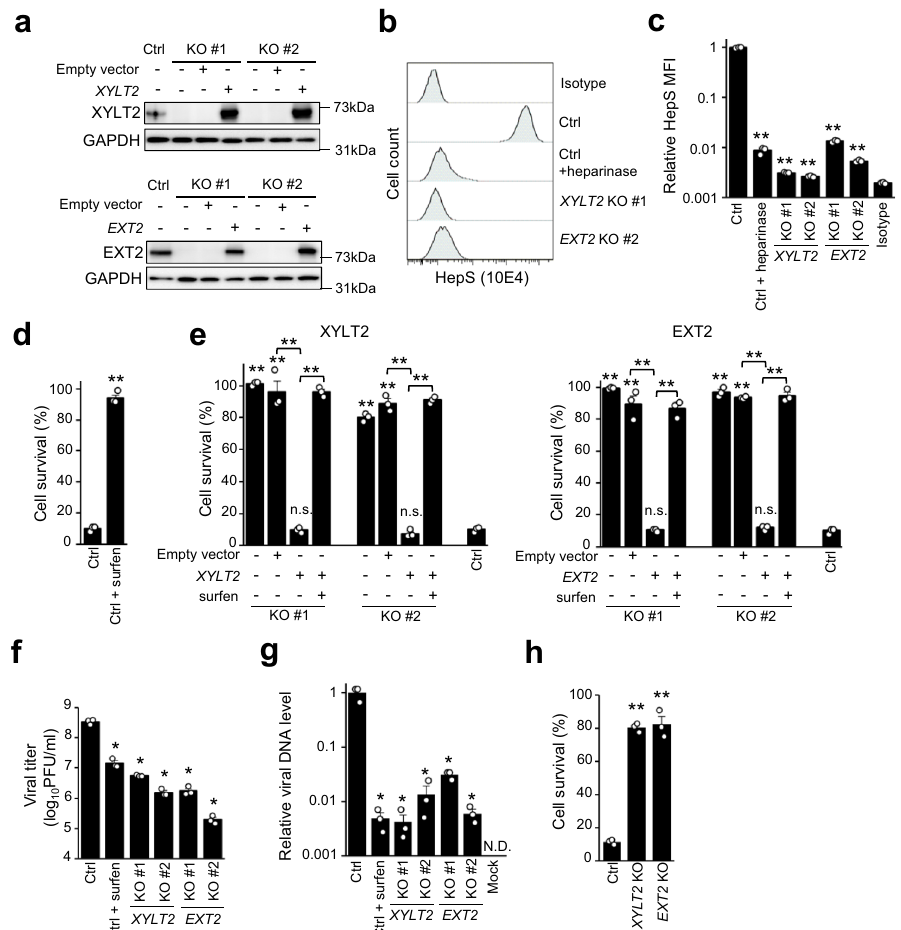
Fig. 2 XYLT2 and EXT2 as essential genes for HSV-1 binding and infection. a Western blotting analysis con fi rming the absence or complementation of XYLT2 , the EXT2 expression in KO, and rescued clones of HAP1 cells. b , c HepS expression analysis by FACS. After treatment with or without heparinase for 1 h at 37 °C, the cells were stained using an anti-HepS antibody. The graph summarized the mean fl uorescent intensity (MFI) of the HepS expression analysis of three independent experiments ( c ). Results are presented as means ± SEM. Viability of the nontargeting control clone ( d ) and the XYLT2- and EXT2 -KO clones ( e ) of HAP1 cells after HSV-1 infection. The cells were either pretreated with 5 μ M surfen hydrate or DMSO and infected with HSV-1 at a MOI of 9. The cell viabilities were measured via the MTS assay at 48 hpi. The results are presented as means ± SEM of three independent experiments. f Progeny virus production of HSV-1 in the control, XYLT2- KO, and EXT2 -KO clones of HAP1 cells. Following surfen hydrate or DMSO treatment, the cells were infected with HSV-1 at a MOI of 1. The progeny viruses were collected at 48 hpi and titrated via the plaque assay. The results are presented as means ± SEM of three independent experiments. g Binding of HSV-1 in the control, XYLT2- KO, and EXT2 -KO clones of HAP1 cells. After surfen hydrate or DMSO treatment, the cells were adsorbed with HSV-1 at an MOI of 50 for 1 h and 4 °C. The nontargeting control cells that were mock-infected with PBS were used as a negative control. After removing the residual viruses, the viral DNA was extracted and quanti fi ed using real-time PCR. The results are presented as means ± SEM of three independent experiments and shown as the relative DNA level of the control cells. h Viability of the nontargeting control clone, XYLT2 -KO, and EXT2 -KO human retinal pigment epithelial-1 cell clones after HSV-1 infection. The cells were infected with HSV-1 at an MOI of 9. Then, the viabilities were measured via the MTS assay at 48 hpi. The results are presented as means ± SEM of three independent experiments. Asterisks, p < 0.05; Double asterisks, p < 0.01; n.s. not signi fi cant; N.D. not